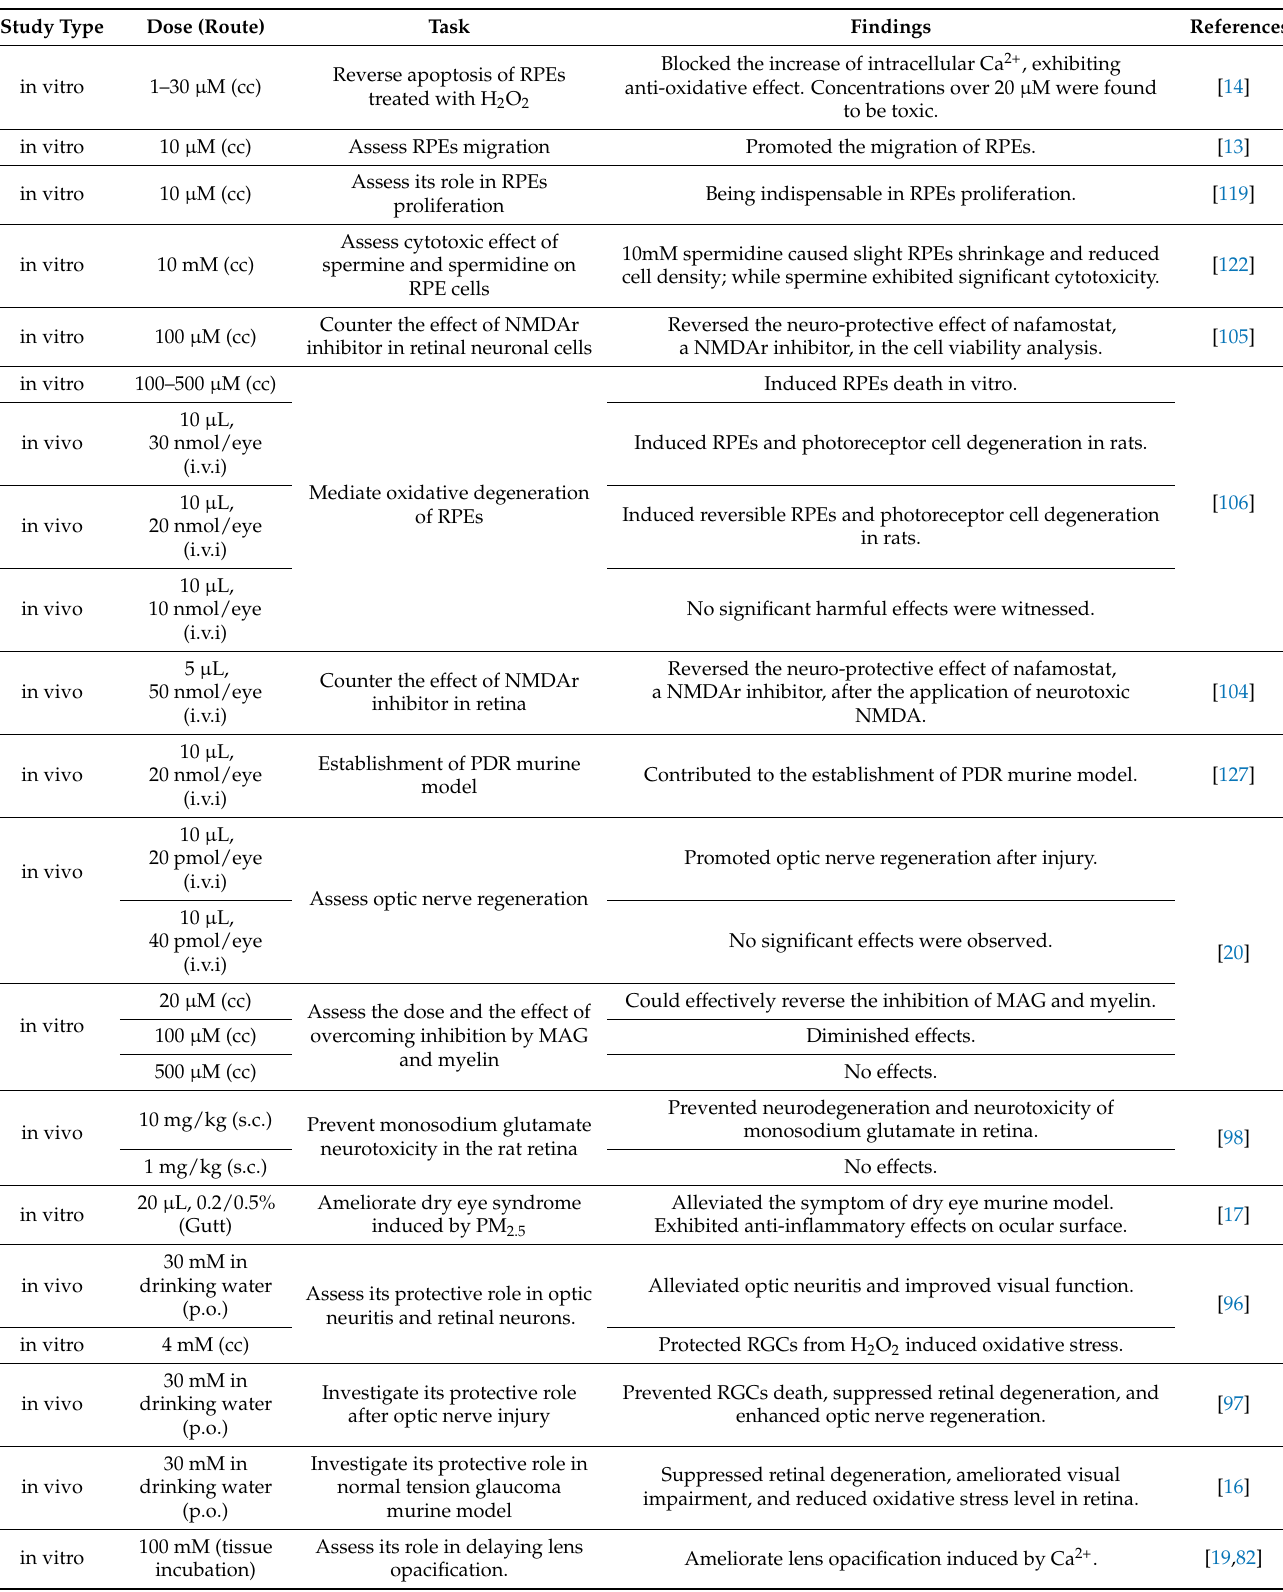
Table 2. A comparison between different routes and doses